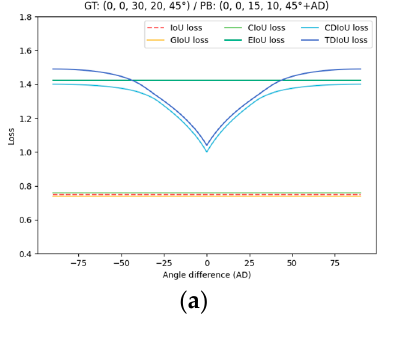
Figure 6. Comparison between different IoU-based losses. ( a ) Different IoU-based loss curves versus angle differences; ( b ) some examples from ( a ). When B pb and B gt with coincident centroids are in a containment relationship and their widths and heights are constant, GIoU loss, CIoU loss, and EIoU loss all degenerate into the original IoU loss. In contrast, our TDIoU loss (the navy blue curve) is still able to stably reflect the angle difference and is informative for learning.